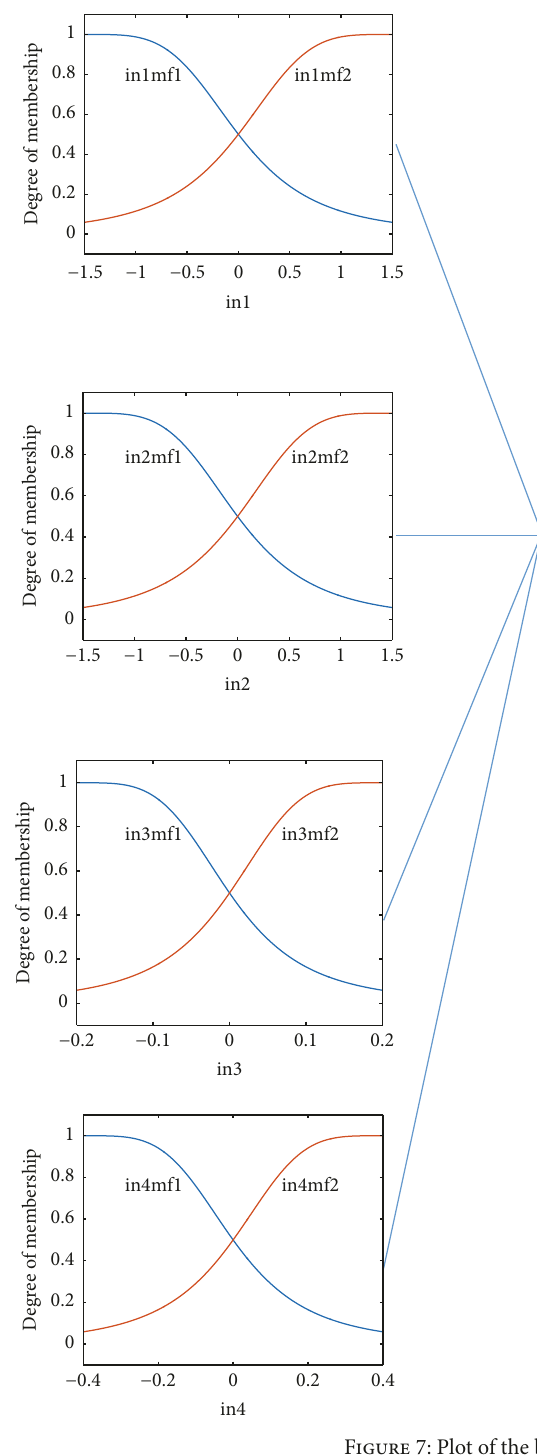
Figure 7: Plot of the ball and beam fuzzy system